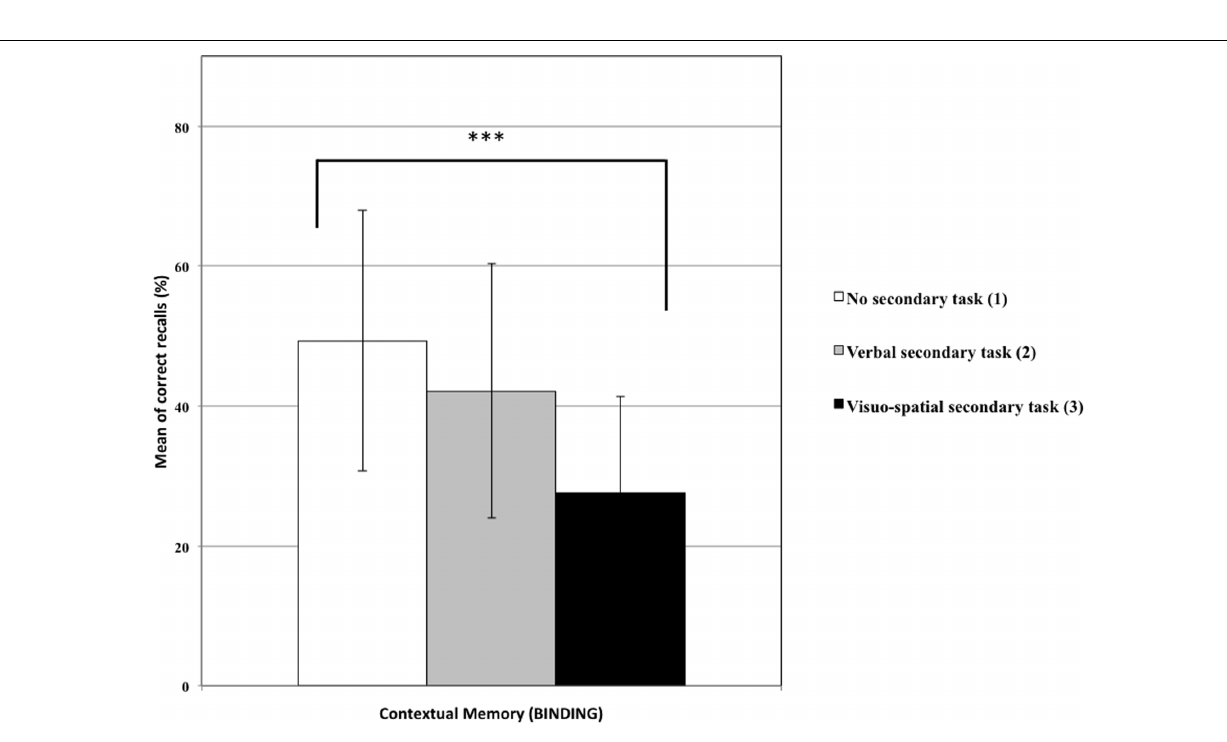
FIGURE 4 | Percentage of contextual memory (binding) for the three experimental conditions (with standard deviation). Condition 3 led to fewer bindings than condition 1 ( ∗∗∗ p <